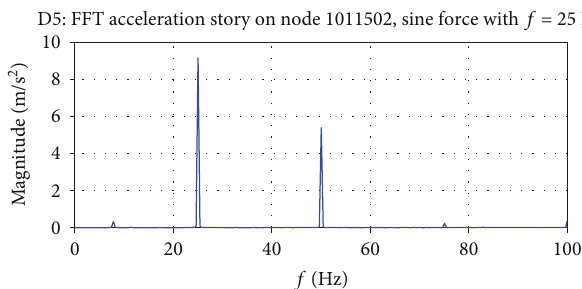
Figure 31: D5, direct response FFT, 25 Hz sine excitation.